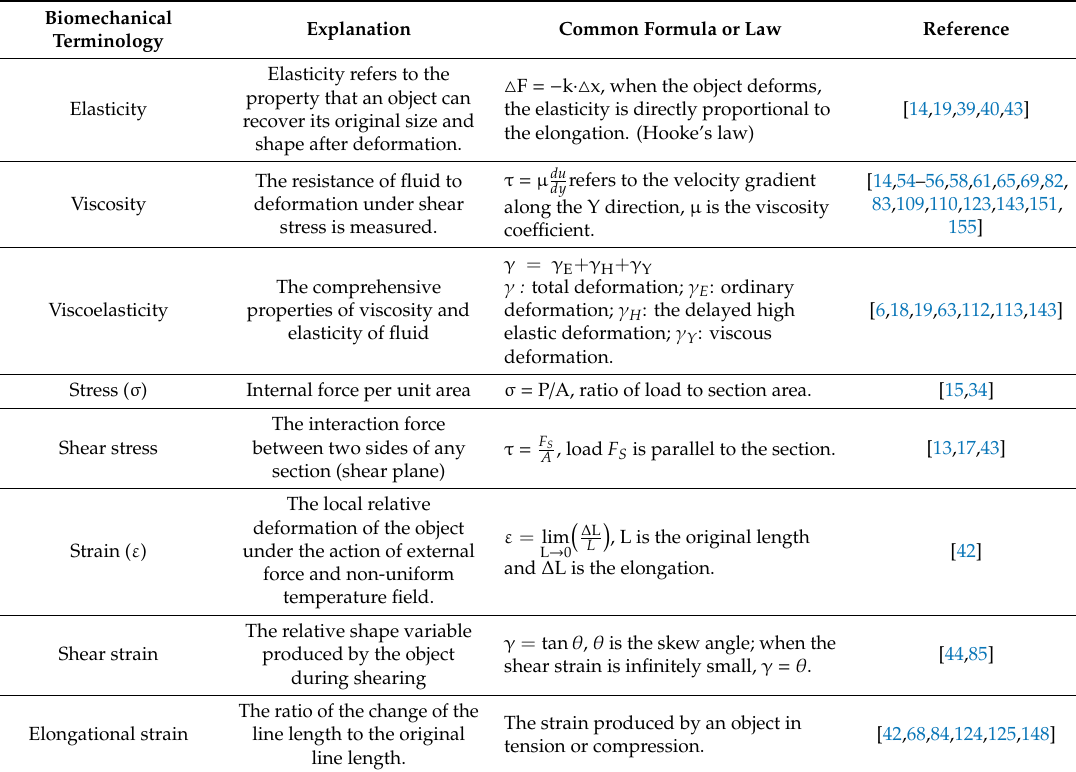
Table A1. Main biomechanical parameters and common